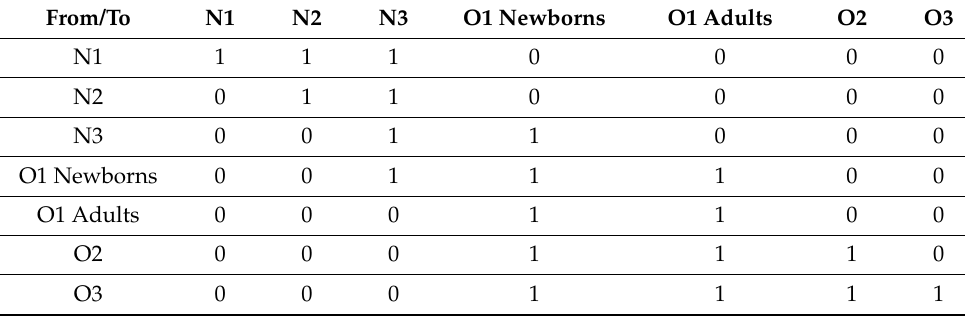
Table 6. Nurse matrix for Model 1 for the Perinatology Care System. From/To